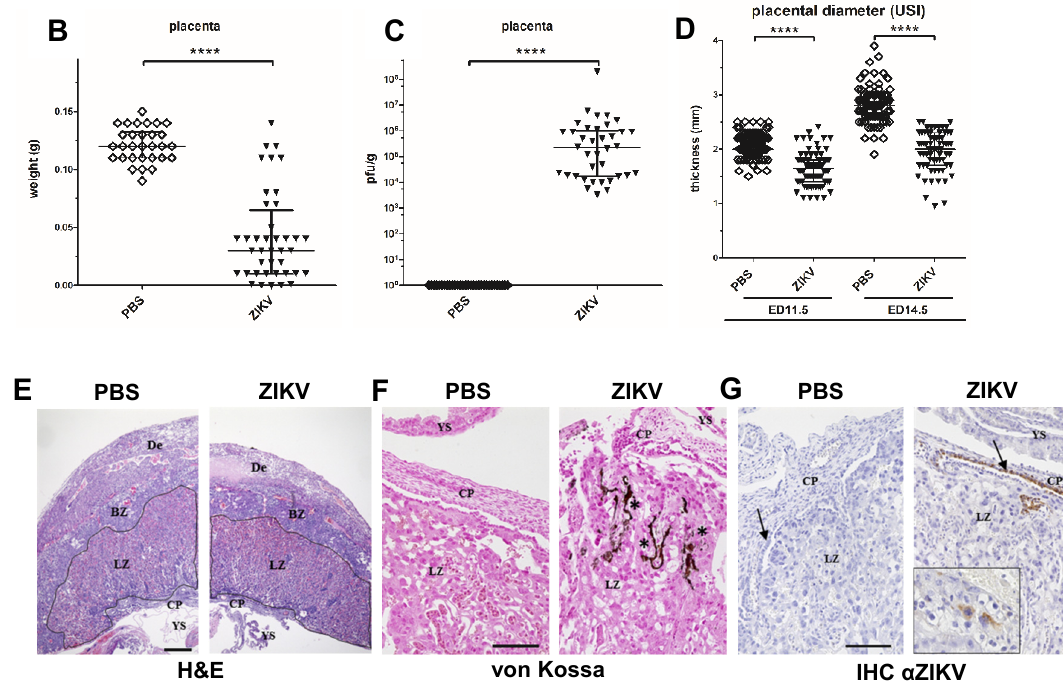
Figure 3. ZIKV induced changes in the placenta; ( A ) Measurement of placenta thickness by ultrasound imaging. Representative images from ED 10.5, 11.5, 14.5, and 15.5 are depicted for PBS control mice and ZIKV-infected mice; ( B ) Comparative evaluation of placental weights on ED 16.5 in sacrificed mice ( n = 8–10 mice per group; di ff erences between individual groups were analyzed by Mann–Whitney test. Error bars indicate the interquartile range (IQR) from the median. Asterisks represent statistically significant di ff erences between two groups: **** p < 0.0001; ( C ) ZIKV challenge of pregnant mice results in highly productive ZIKV infection of placental tissues, virus titers in placentas after ZIKV infection. At the end of the experiments (ED 16.5) placentas were removed and homogenized, and the amount of virus was determined by plaque assays ( n = 31–39 placentas per group); data are representative of at least two independent experiments; di ff erences between individual groups were analyzed by Mann–Whitney test. Error bars indicate the interquartile range (IQR) from the median. Asterisks represent statistically significant di ff erences between two groups: **** p < 0.0001; ( D ) placental diameter determined by ultrasound-based measurements comparing ED 11.5 and ED 14.5 ( n = 31–39 placentas per group); data are representative of at least two independent experiments; di ff erences between individual groups were analyzed by Mann–Whitney test. Error bars indicate the interquartile range (IQR) from the median. Asterisks represent statistically significant di ff erences between two groups: **** p < 0.0001; ( E – G ) (De) decidua, (BZ) basal zone, (LZ) labyrinth zone, (CP) chorionic plate, and (YS) yolk sac. Histological analysis of placental tissues following ZIKV infection; ( E ) Placentas were removed, and sections of the organs were routinely stained with hematoxylin and eosin (HE) Bar = 300 µ m; ( F ) Sections of tissues were treated with von Kossa staining to identify tissue calcification Bar = 100 µ m; black asterisks indicate accumulations of dystrophic mineralization in the basal LZ of ZIKV-infected mice; ( G ) Placenta, ED 16.5, immunohistochemical staining with α ZIKV. Variable, prominent intracytoplasmic antigen expression in the chorionic epithelium (black arrow), in spongiotrophoblasts and glycotrophoblasts (inset) of the ZIKV-infected group, whereas all placentas of the control group including their chorionic epithelium (black arrow) were immunonegative. Bar = 100 µ m.